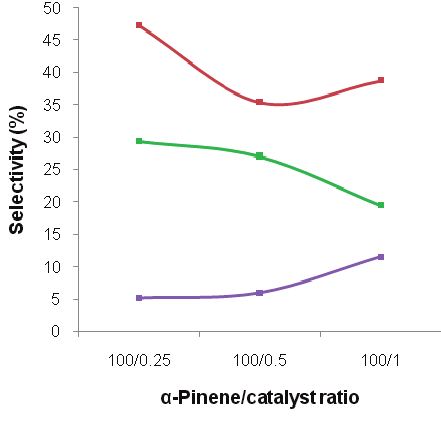
camphene, limonene and terpinolene at 130°C, using SiW O /SiO catalyst. H 4 12 40 2